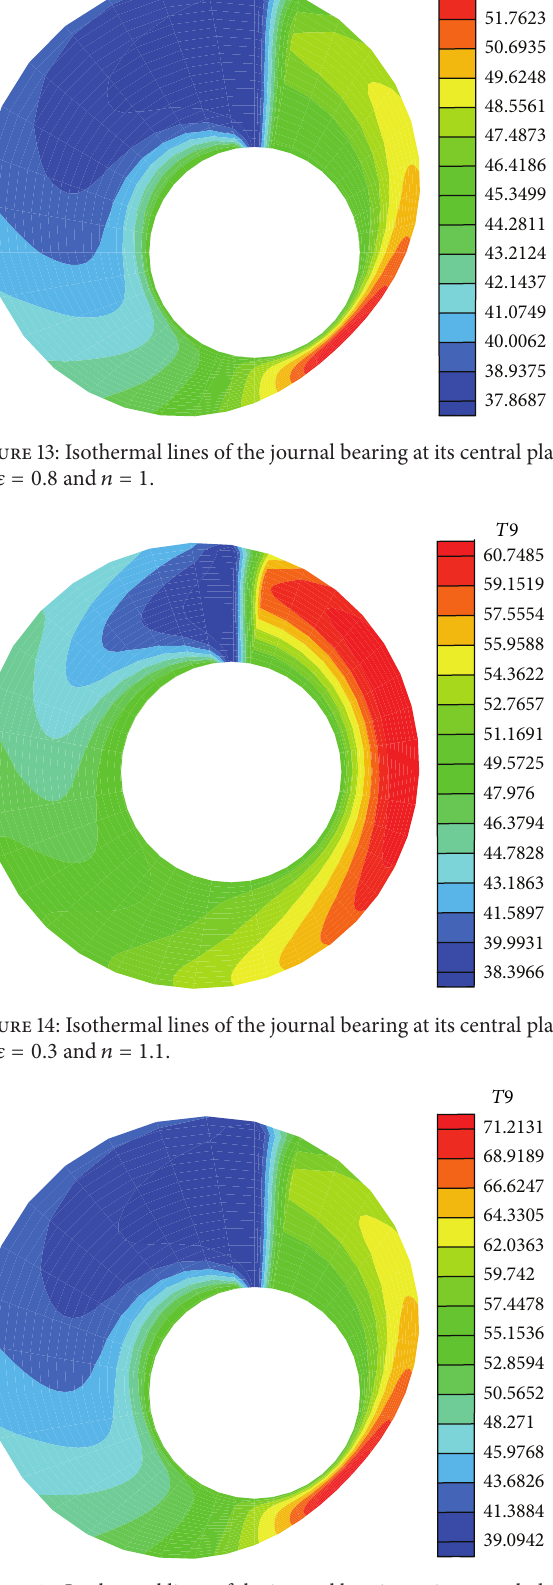
Figure 15: Isothermal lines of the journal bearing at its central plan for 𝜀 = 0.8 and 𝑛 = 1.1